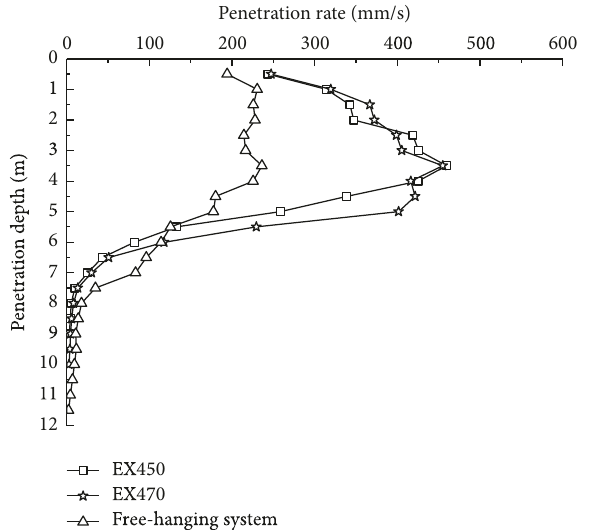
Figure11:Penetrationrateofpilesdriveninsite3versuspenetration depth.